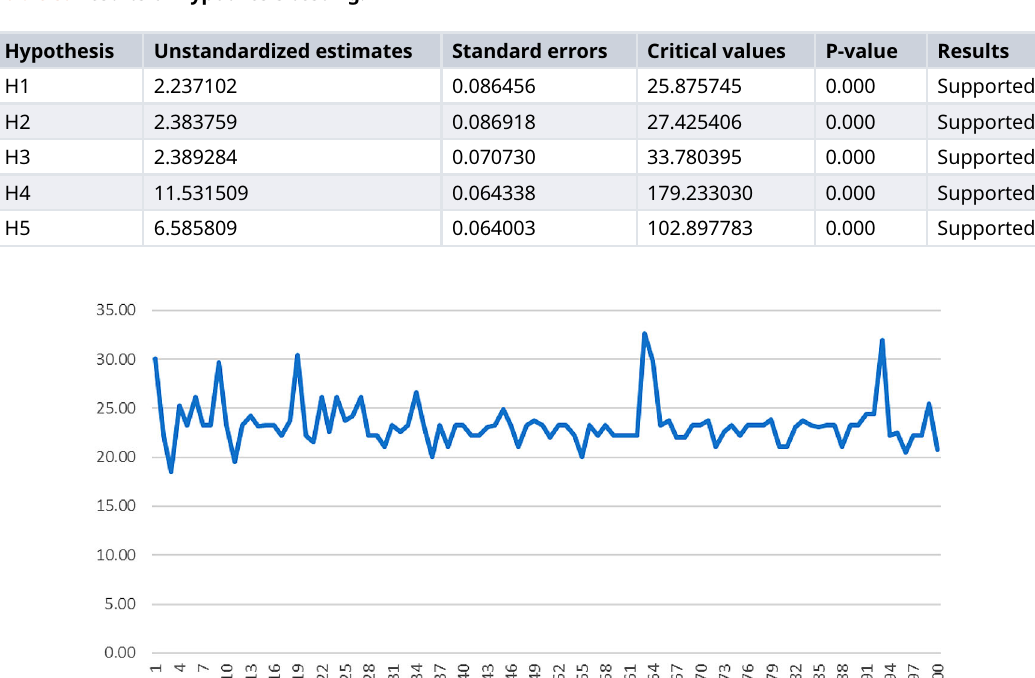
Figure 2. Five core job characteristics of the AML system. Table 5. Results of hypothesis testing.